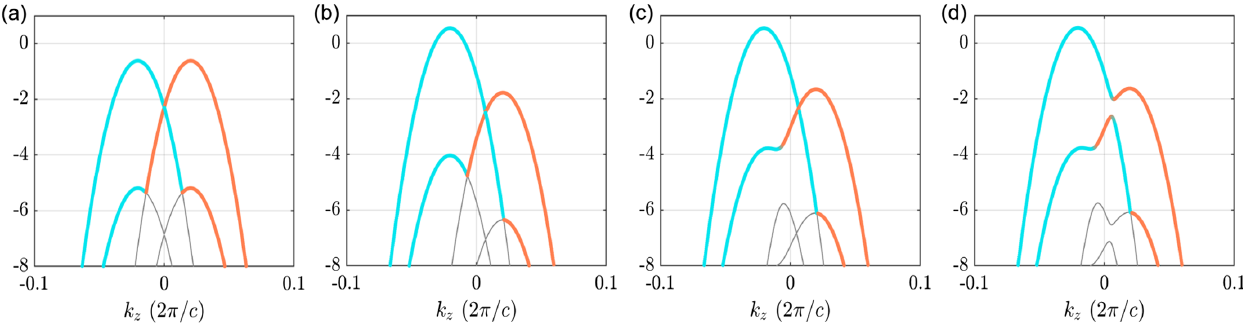
added, (c) in-plane Z T